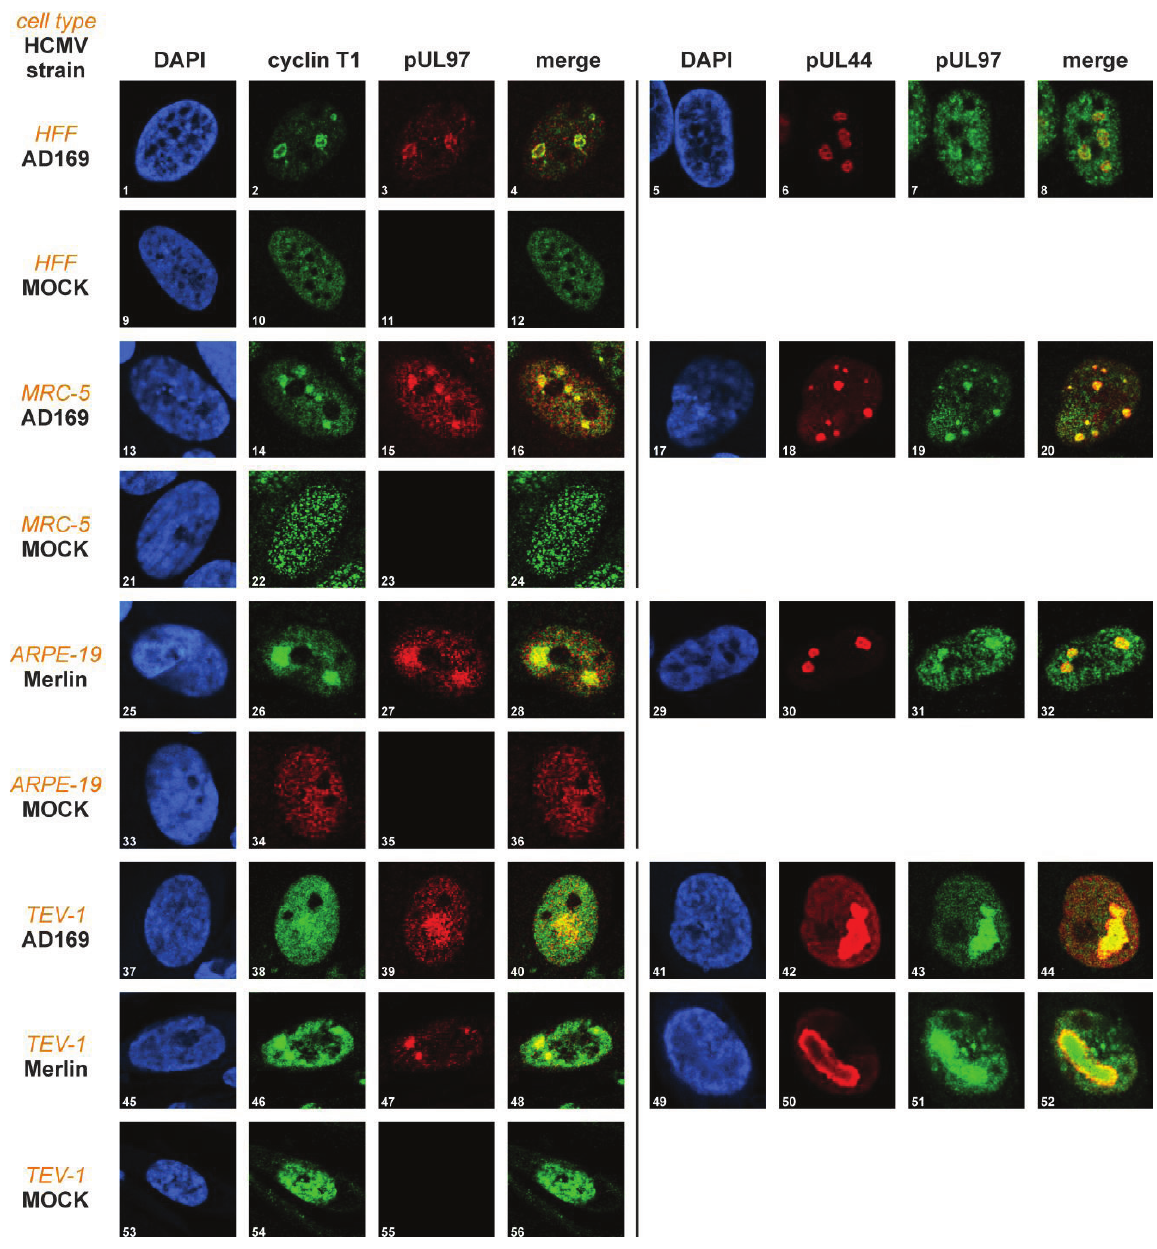
Figure 3. Comparison of the pUL97-cyclin T1 intracellular localization in four human cell types infected with two different HCMV strains using immunofluorescence analyses. HFF, MRC-5, ARPE-19 and TEV-1 cells were infected with HCMV AD169 or HCMV Merlin at various MOIs (1 – 8: MOI 0.5; 13 – 20: MOI 0.09; 25 – 32: MOI 0.03; 37 – 52: MOI 0.01). Cells were fixed within a range of late time points post-infection (1 – 12: 4 dpi, 13 – 36: 6 dpi, 37 – 56: 5 dpi) and immunostained with pAb(r)-cyclin (pAb, polyclonal antibody) T1, mAb UL97/pAb-UL97 (mAb, monoclonal antibody) and mAb-UL44. MOCK, uninfected